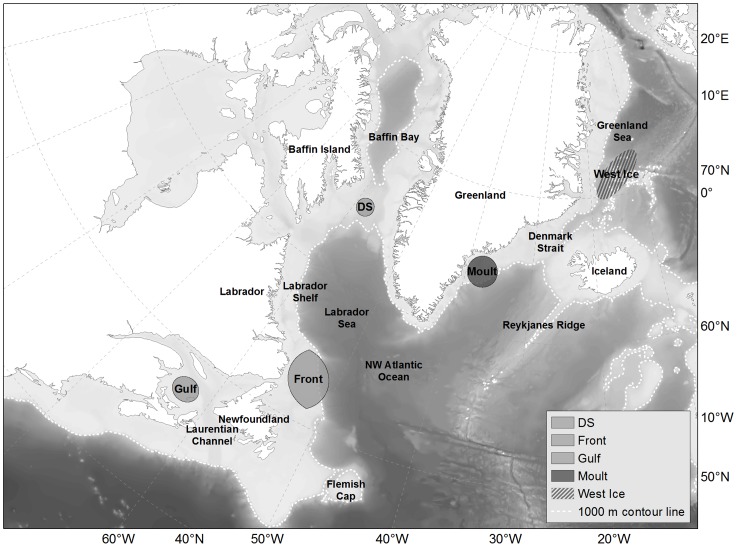
Map over the study area: Moulting area in southeast Greenland and breeding areas in Davis Strait (DS), The Front and The Gulf.Bathymetry of the study area is presented as backdrop in grey scale. Dashed white line is the 1,000